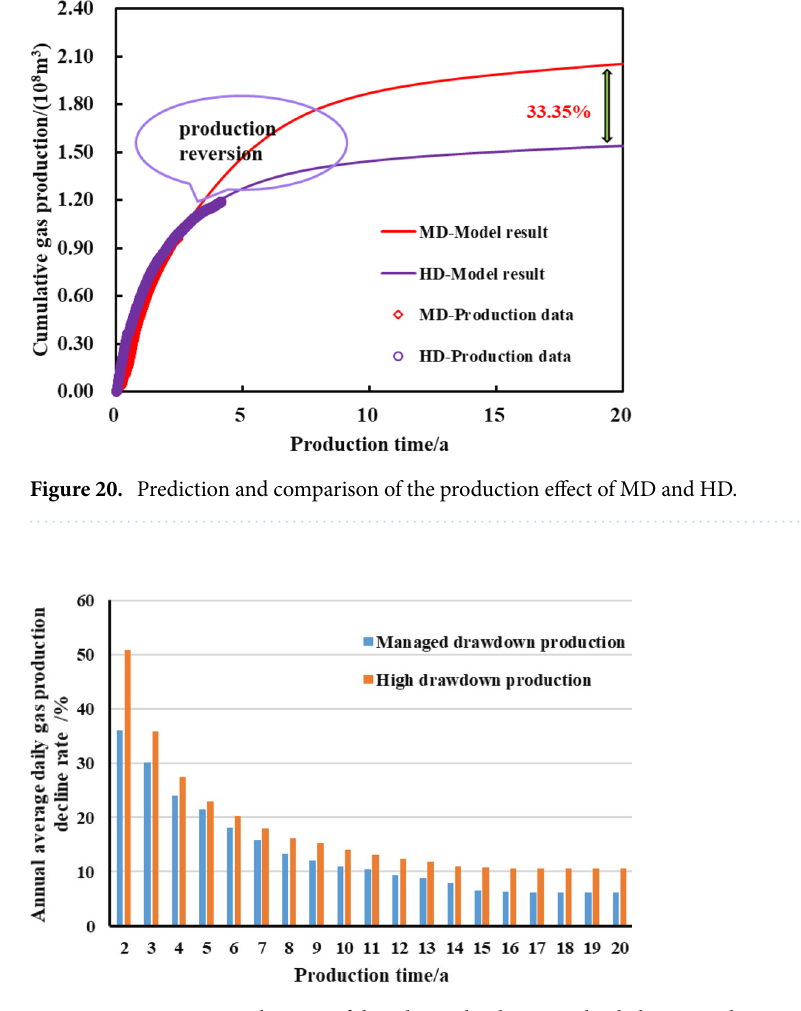
Figure 21. Comparison diagram of the relationship between the daily gas production decline rate and production time of gas wells with MD and